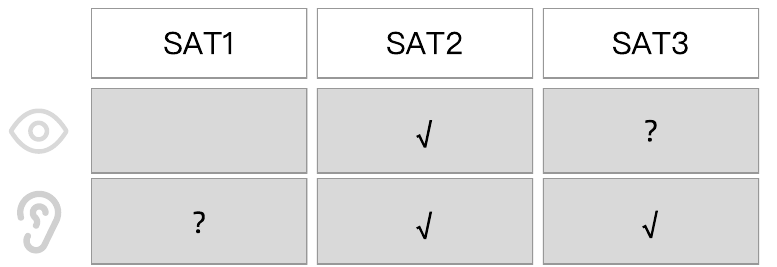
Figure 4. SAT model assumptions for multimodal